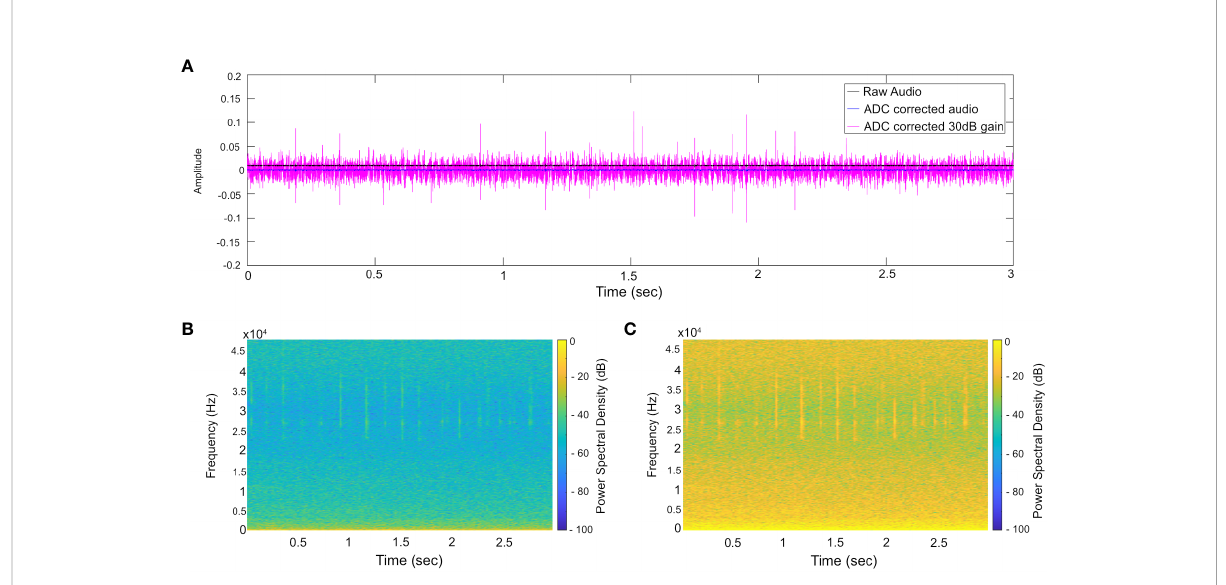
FIGURE 4 Conditioning applied to COMPASS acoustic fi les, using exemplar data containing echolocation clicks. (A) time domain showing raw data (black line) with positive bias (+0.01), corrected data (blue line), and data after application of 30 dB gain (magenta). (B) Raw spectrogram without bias correction, or gain. Clicks are only faintly visible. (C) Spectrogram after bias and application of a gain, emphasizing spectral content of which the model will detect ensuring consistency with the other data sources being